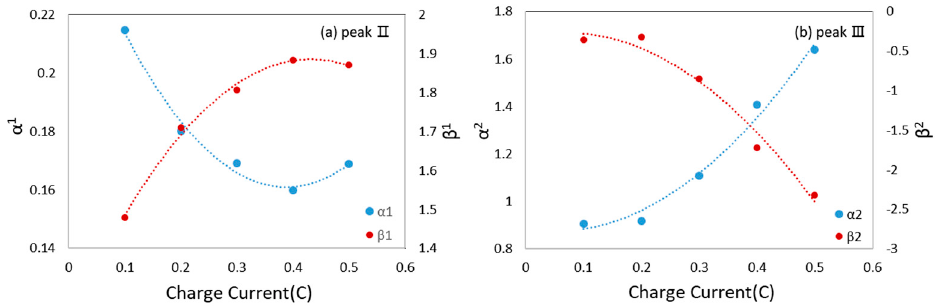
Figure 4. The correlation between coefficients and current rate: ( a ) peak II; ( b ) peak III. The relationship can be fitted by nonlinear functions shown in the Equations (3) and